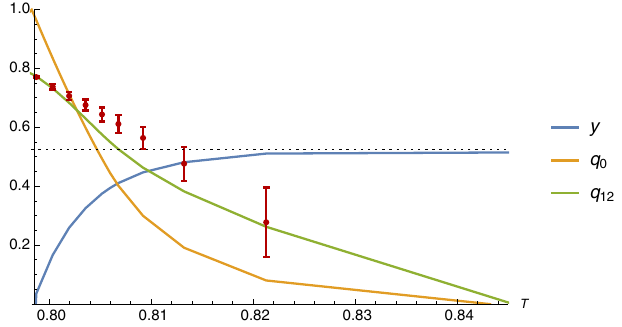
FIG. 20. Assuming the dynamics relaxes on the marginal q manifold with energy E 12 Þ and fixing the energy from the th ð large-time extrapolation of the numerical data, which in turn fixes the value for q 12 , we can compute analytical values for the remaining aging parameters, namely, q 0 and y ¼ ∂ E Σ . While the estimate of q 12 is compatible with the large-time extrapolation of C ð t; 0 Þ (red points with error in the figure), the other aging parameters are far from those measured in the actual